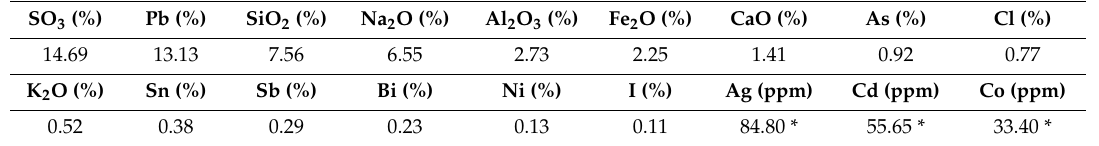
Figure 2. XRD diffractogram of copper smelter flue dust. Table 1. Chemical composition of copper smelting Table 1. Chemical composition of copper smelting dust.